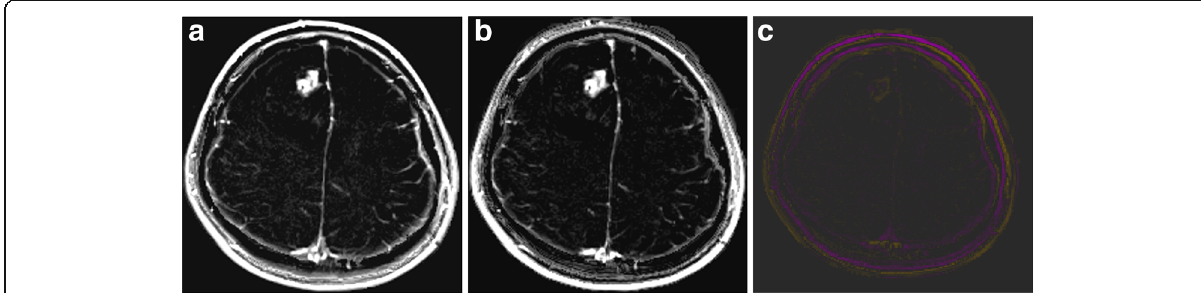
Fig. 5 Comparison of quantitative enhancement (QE) maps for gadobutrol ( a ) and gadoteridol ( b ) reveals even very minor differences in contrast enhancement. In this case, the QE change map ( c ) shows that enhancement of the lesion rim (arrow) is slightly different between the agents. Purple indicates that enhancement is brighter after gadobutrol while yellow indicates that enhancement is brighter after gadoteridol